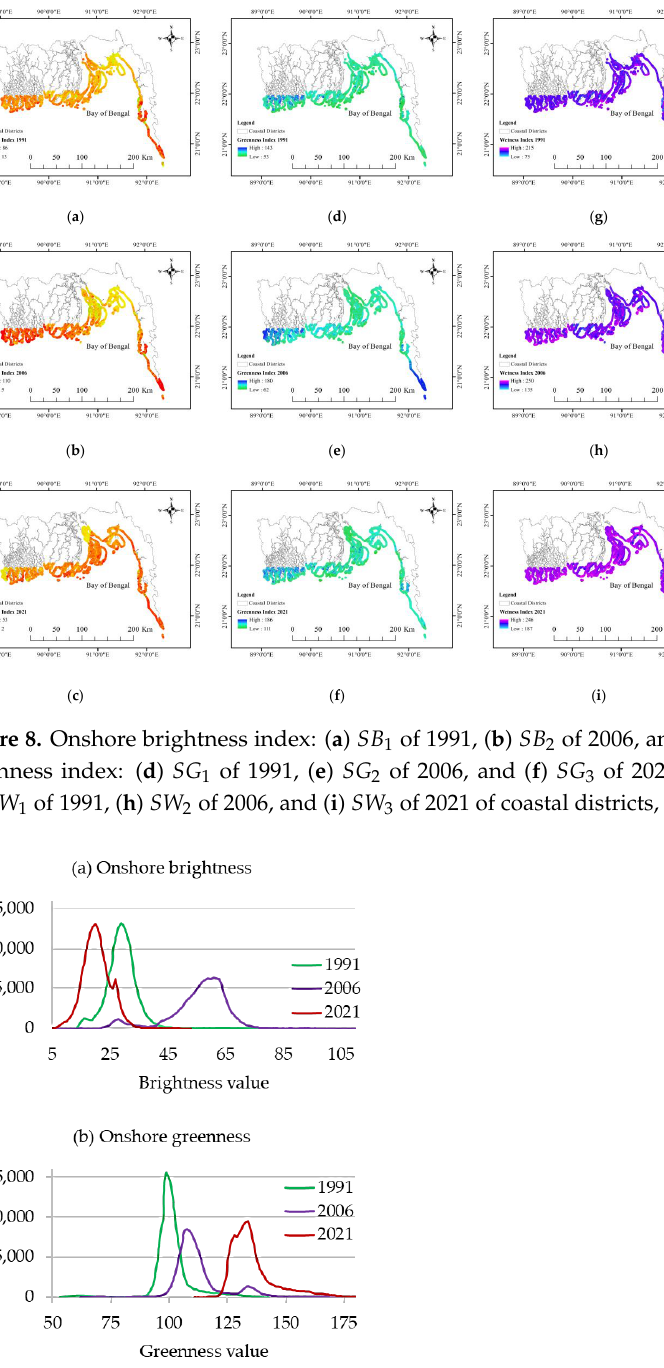
to 67 ( 𝑆𝐵 2 ), and 91.11% ranged from 13 to 28 brightness index values in 2021 ( 𝑆𝐵 3 ). There- fore, onshore brightness increased in 2006 from 1991 and decreased in 2021 from 2006 (Figure 9a).